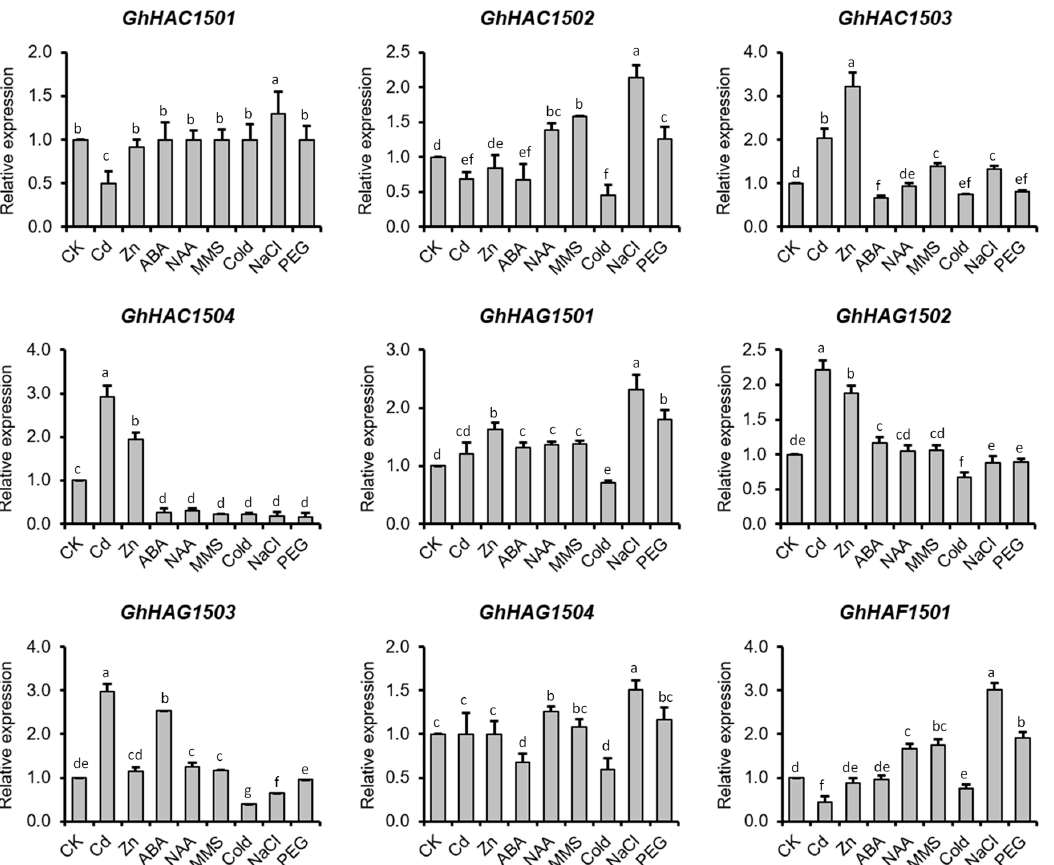
Figure 6. Expression pattern of Gossypium hirsutum HATs in response to abiotic stresses and hormones. RNA from roots after 24 h of CK (control), cadmium (Cd), zinc (Zn), abscisic acid (ABA), auxin (NAA), DNA damage (MMS), cold, salt (NaCl), and drought (PEG4000) was extracted and reverse transcribed. UBQ7 was used as an internal control for qRT-PCR. The data presented are the average of three biological replicates. Different letters indicate significant difference by least significant difference (LSD) test ( p ≤ 0.05). Bar = SD.